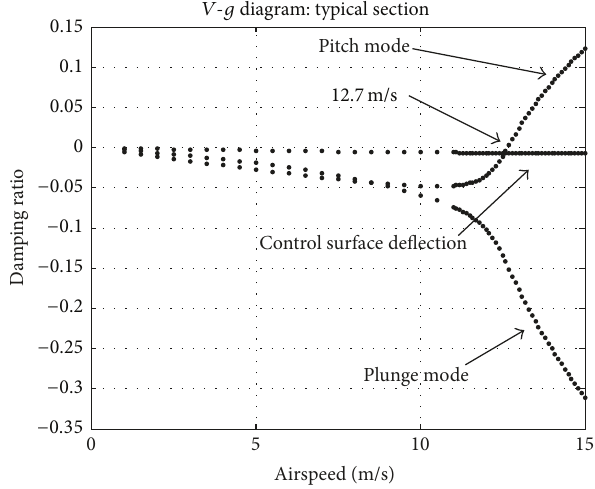
Figure 3: The nonlinear function 𝑓 range of 𝛽(𝑡) .